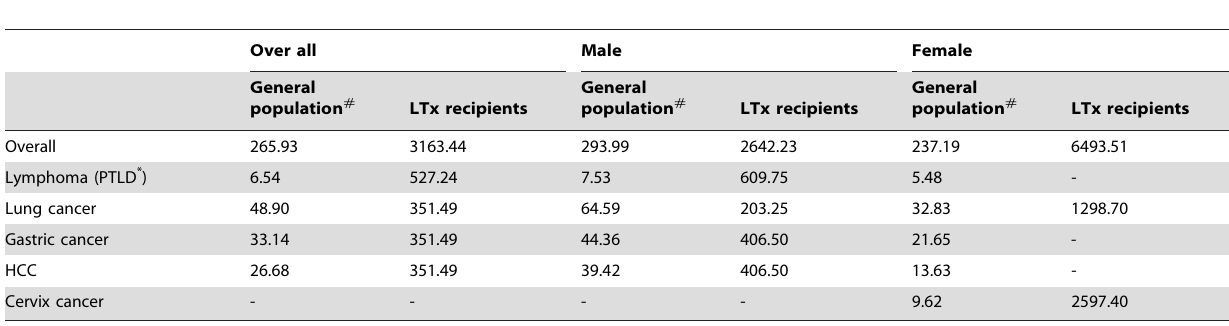
Table 3. Incidence rates of the common cancers in the Chinese general population and liver transplantation patients (per 10 5 persons).